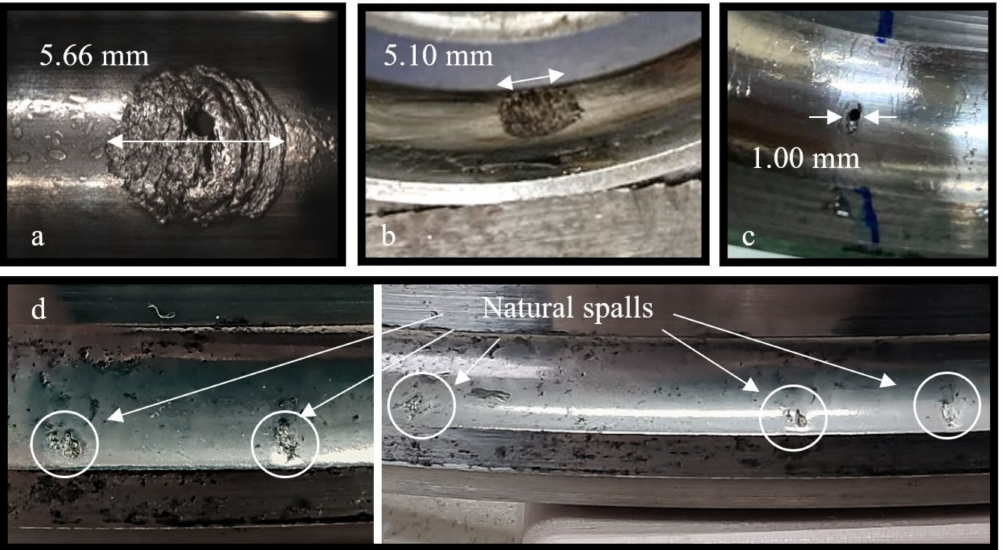
Figure 9. Pictures of spalls in three different experiments: ( a , b ) Examples of spalls from the endurance test and ( c ) the disassembly and reassembly test. ( d ) Examples of several in-service spalls that appeared in a Sikorsky CH-53 helicopter swashplate